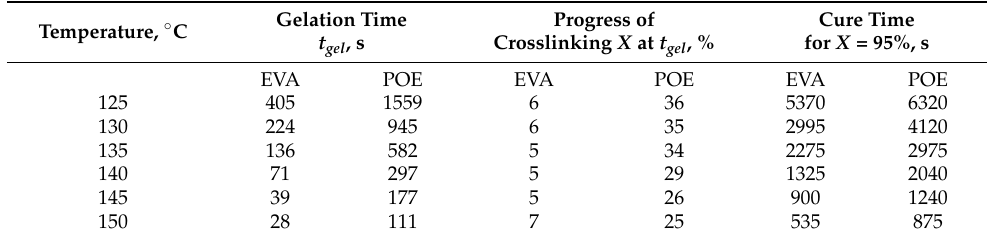
Table 2. Temperature-dependent gelation time, progress of crosslinking at gelation time and cure time to achieve a progress of crosslinking of 95% for UV-transparent EVA and POE. Gelation Time Temperature, ◦ C t gel ,